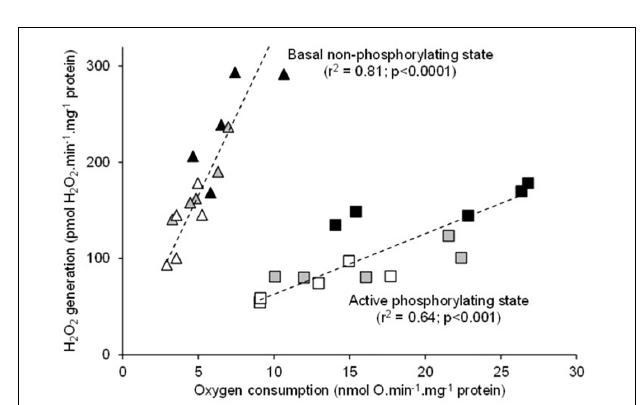
FIGURE 3 | Relationship between the individual H 2 O 2 production and the mitochondrial oxygen consumption rates during fueling with succinate alone (basal non-phosphorylating state) or with succinate and ADP (active phosphorylating state). The individual values show five independent mitochondrial preparations from the liver of toad measured at 20 ◦ C (white circles), at 25 ◦ C (gray circles), and at 30 ◦ C (black